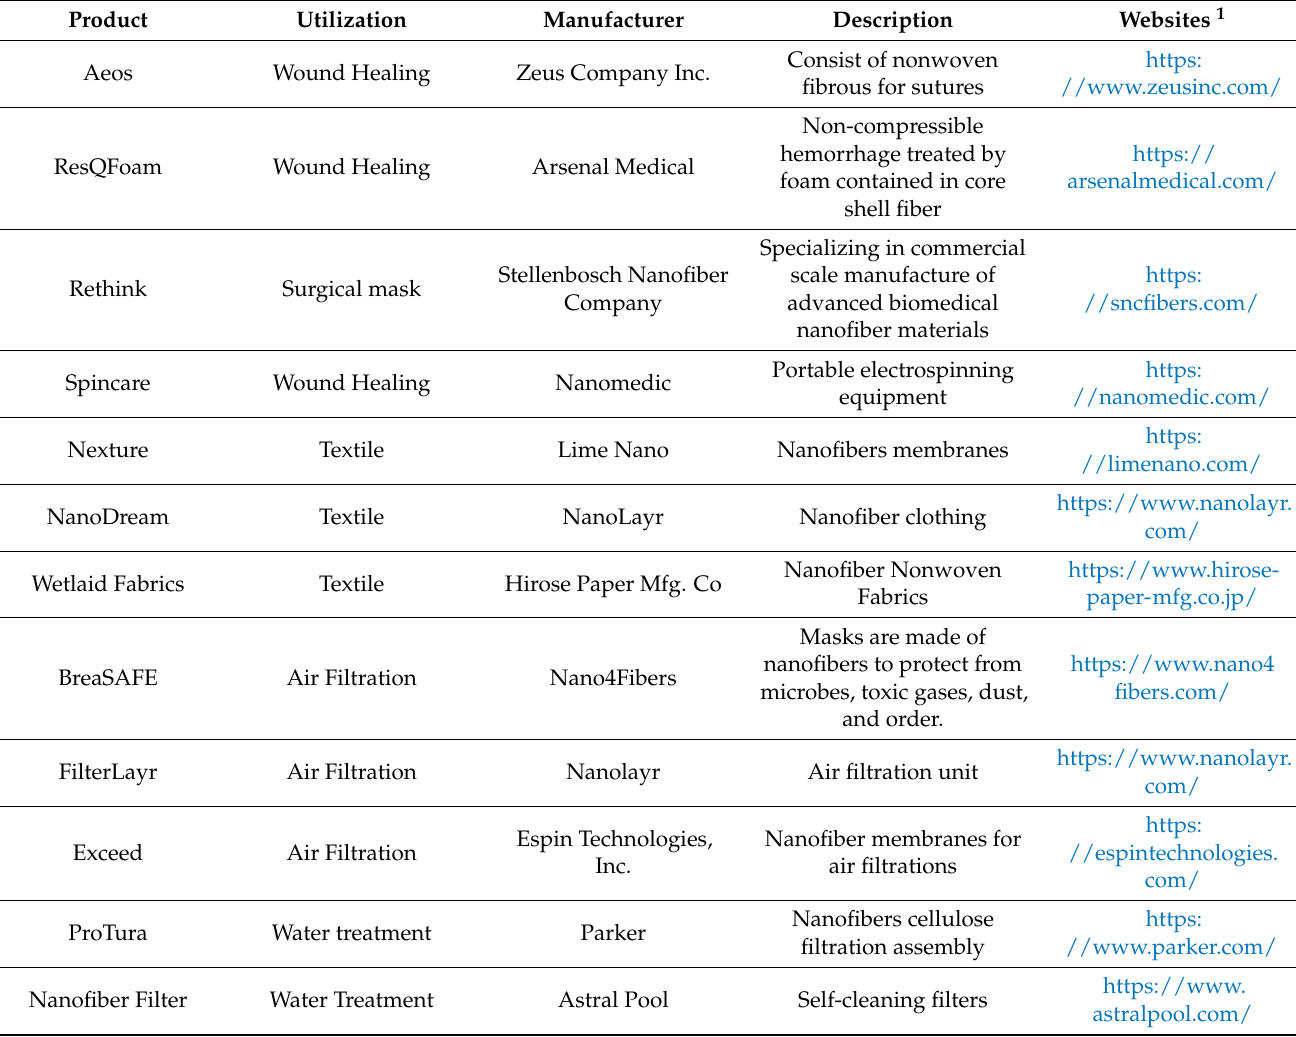
Table 7. Commercial nanofiber products utilized in various